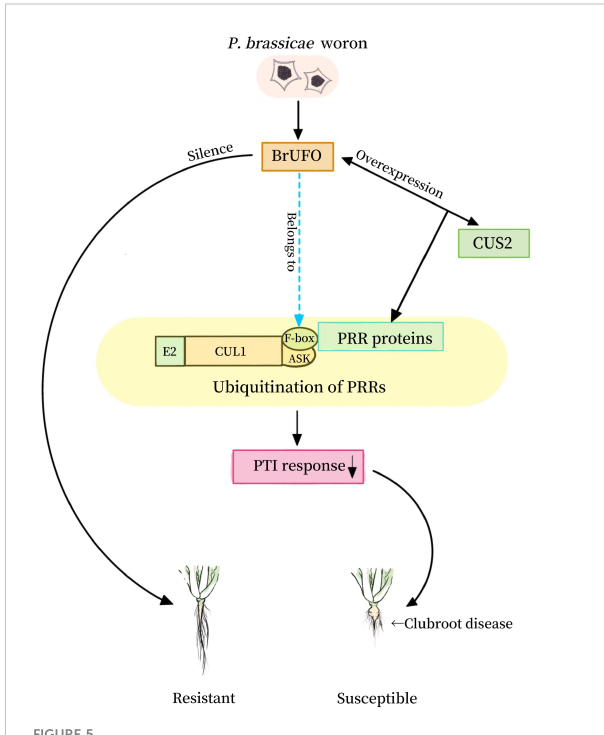
FIGURE 5 Role pattern of BrUFO in Chinese cabbage response to Plasmodiophora brassicae